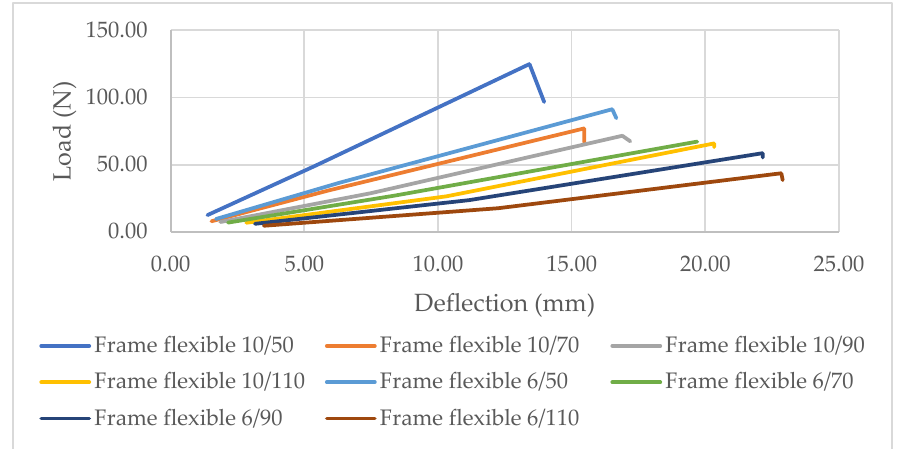
Figure 7. Load-deflection curves for flexibilized plywood samples.